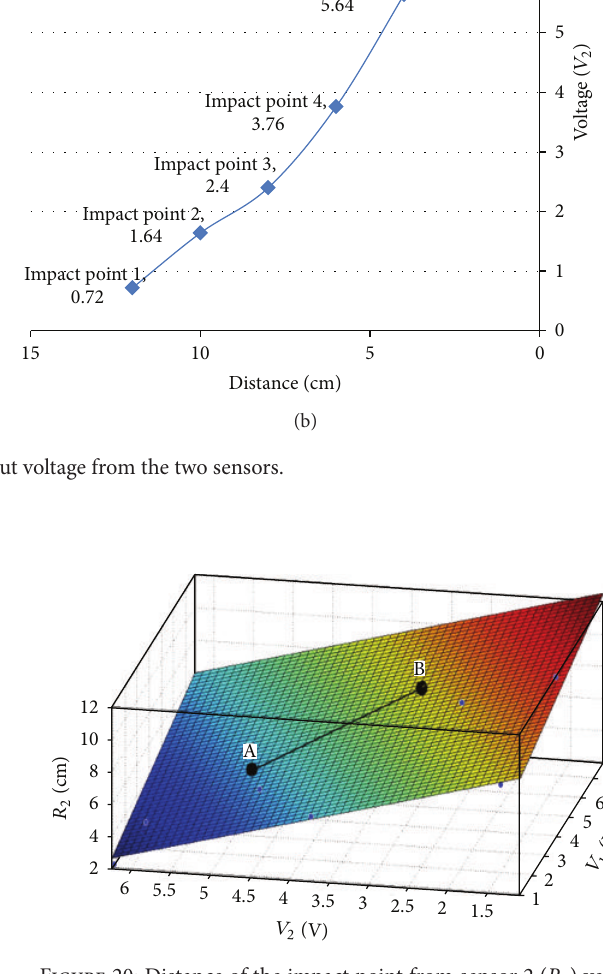
Figure 20: Distance of the impact point from sensor 2 ( 𝑅 2 ) versus the two output voltages from the two sensors ( 𝑉 1 and 𝑉 2